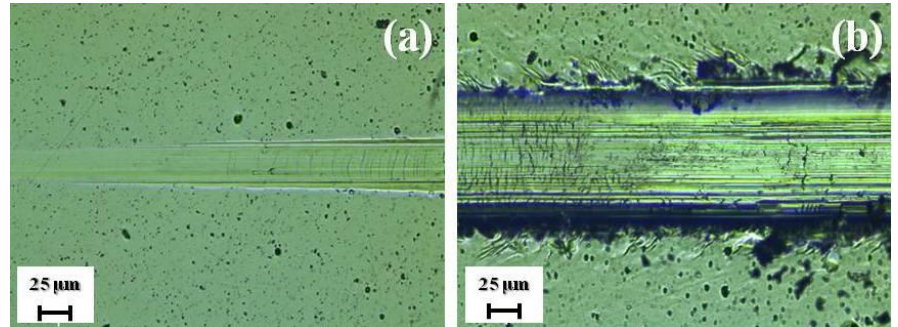
Figure 8. Images of scratch groove formed on the surface of the NiB-Cr 7 C 3 coating: start point ( a ) and end point ( b ).